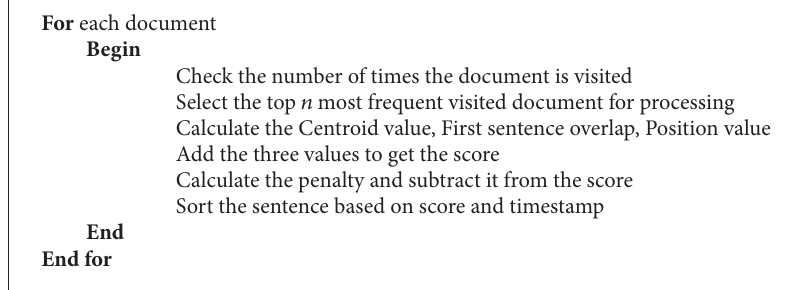
Algorithm 2: For selecting frequent document for processing.